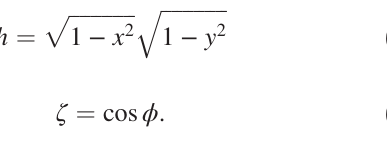
FIG. 4. Specular reflection probability [13], vs. photon energy and angle, for an rms surface roughness of σ ¼ 200 nm. The curves have been calculated from Eq. (1) with R ¼ 1 .